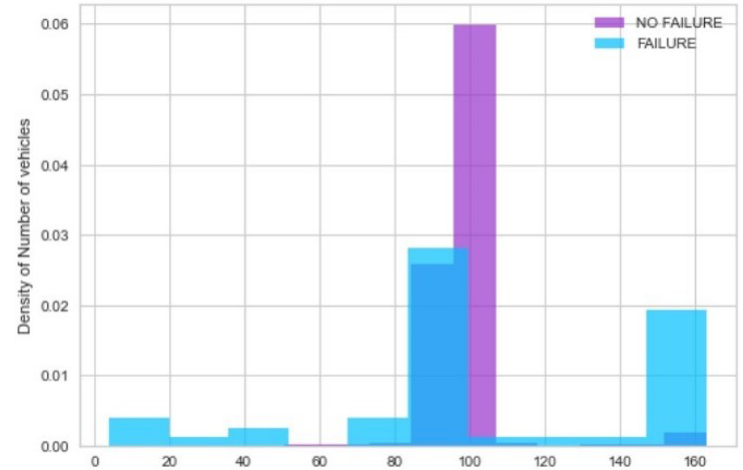
Figure 11. Battery charge